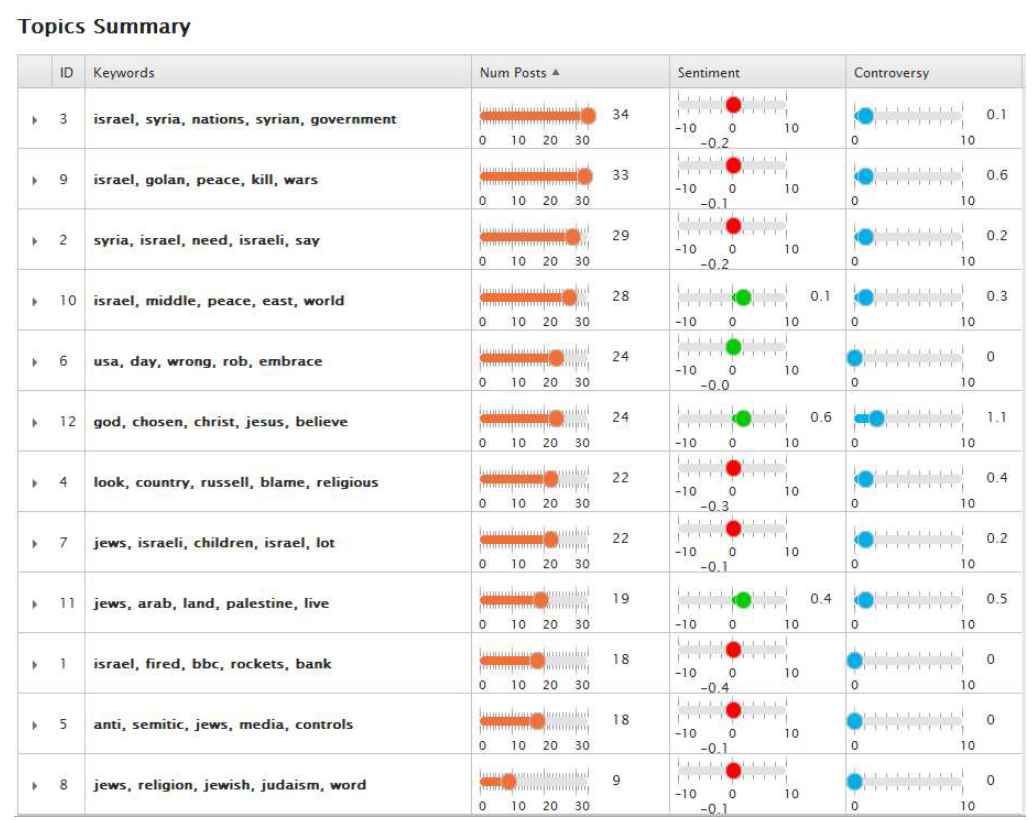
concern aggressive activity in the Golan Heights. The user can click on the arrow to the left of the topic ID, and this will expand the topic group to show the posts inside if required, and an example is shown in Figure